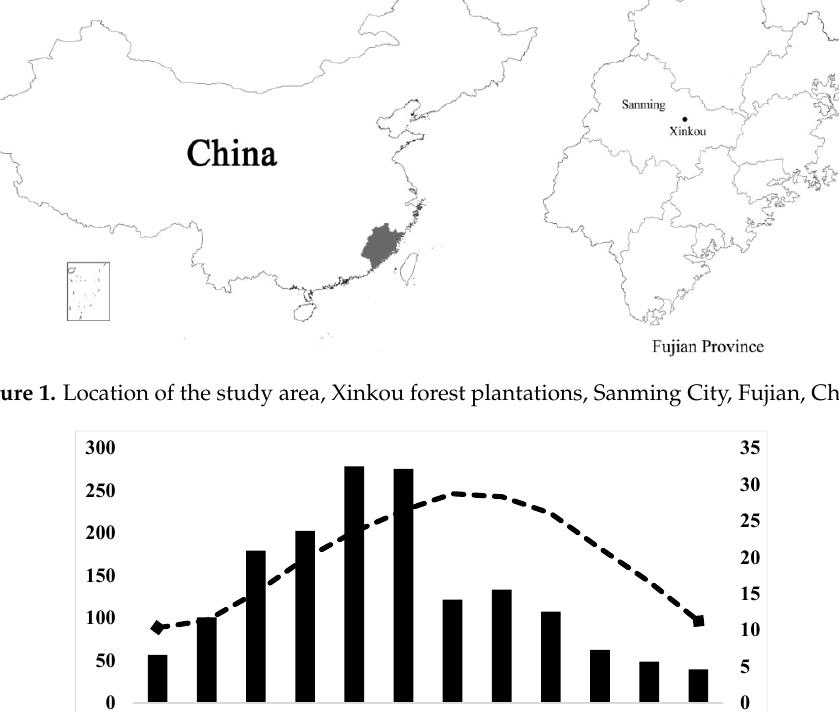
Figure 2. Average monthly precipitation and temperature of the study area in 2017.